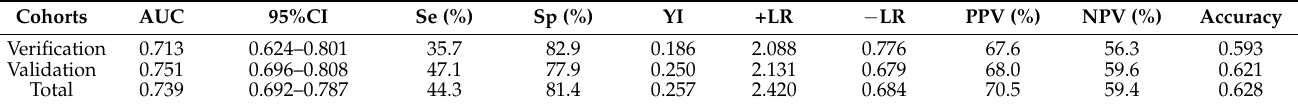
Table 3. The diagnostic value of anti-CXCL8 autoantibody for ESCC.